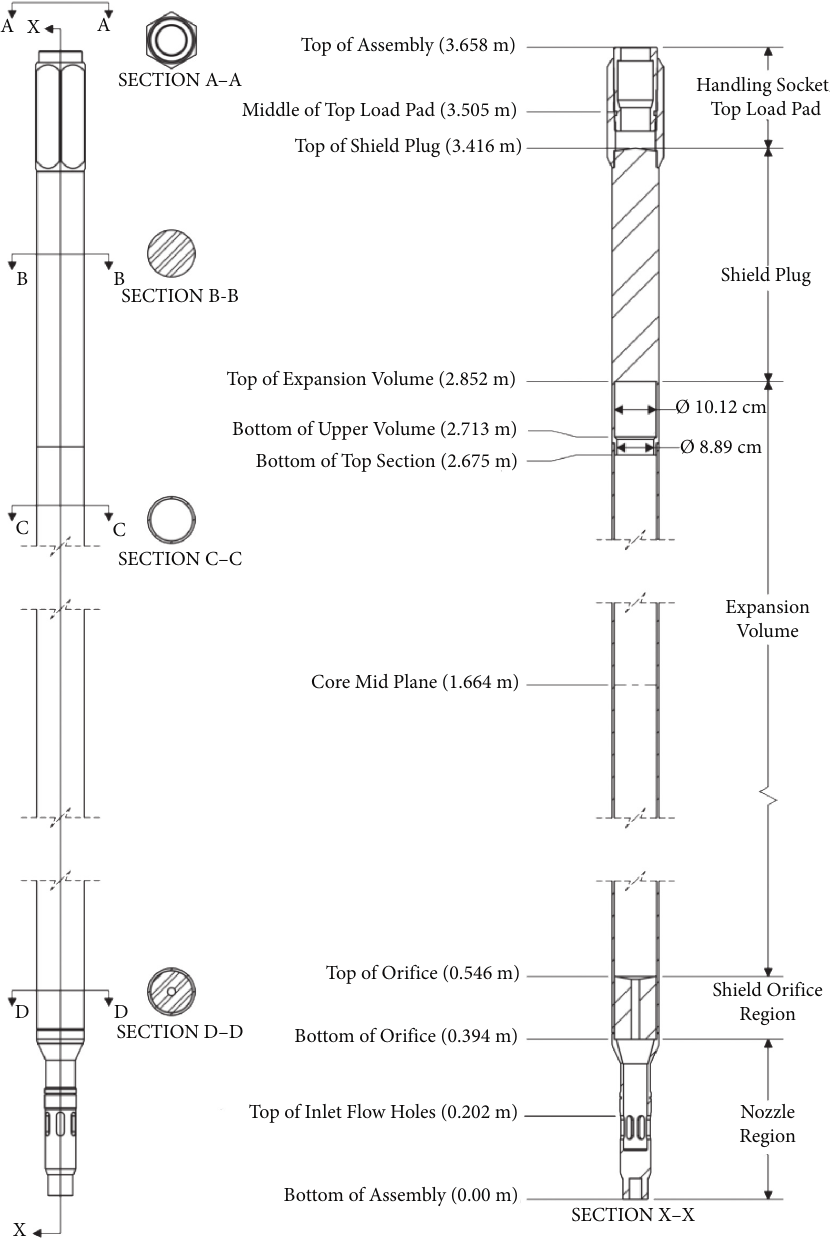
Figure 3: Gas expansion module assembly